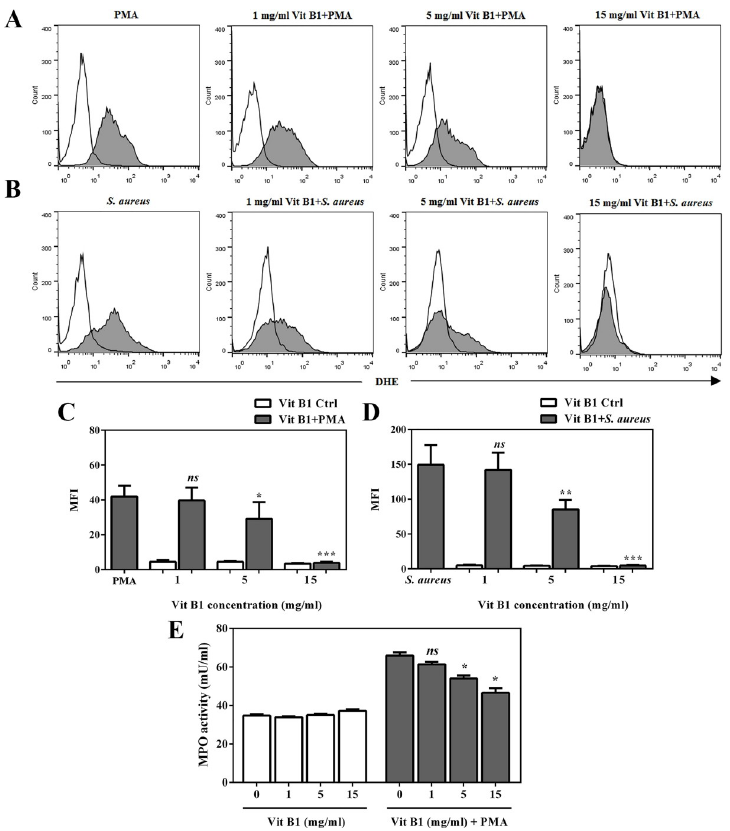
Fig 7. Effect of vitamin B1 on intracellular ROS production. Different concentrations of vitamin B1 were added into purified PMNs at 37˚C for 30 min. (A, B) Representative images of flow cytometry analysis showed ROS release after PMNs were stimulated by 100 nM PMA or S . aureus at a MOI of 10, respectively, in the presence or absence of vitamin B1. (C, D) After stimulation with PMA or S . aureus , quantitative results showed the MFI of ROS generation in vitamin B1-treated PMNs compared with positive control. (E) The MPO activity was measured in vitamin B1-treated PMNs at different doses for 30 min at 37˚C following stimulation with 100 nM PMA for 90 min. The MPO activity was quantified as milliunit/ml (mU/ml). Error bar indicates SEM for n = 3–5. � p < 0.05, �� p < 0.01, ��� p < 0.001, and NS-non significant.